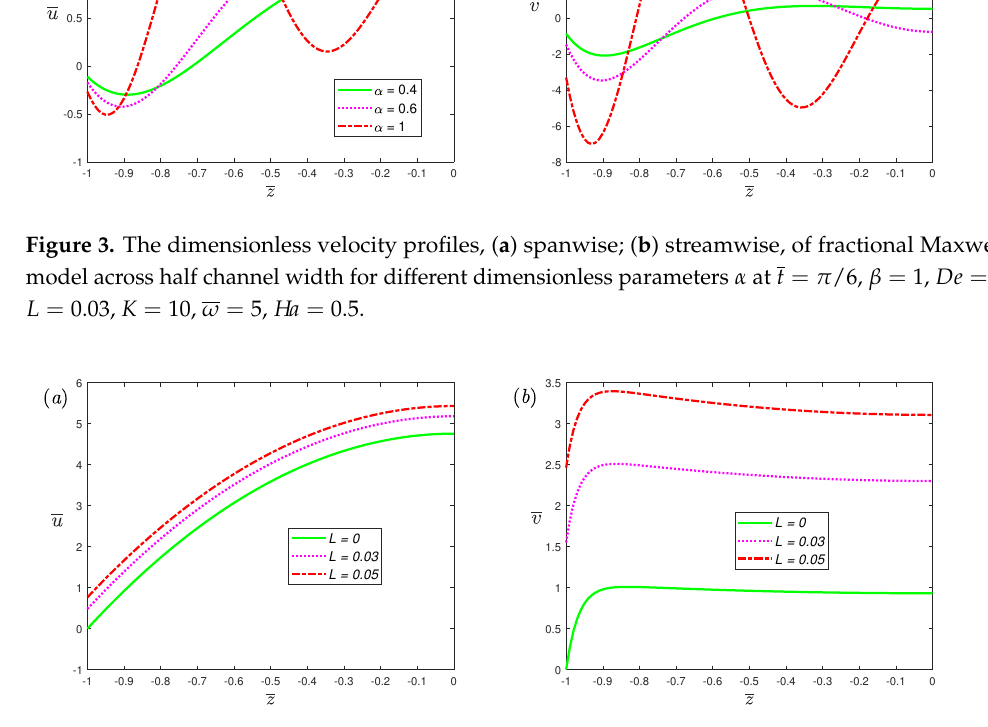
Figure 4. The dimensionless velocity, ( a ) spanwise; ( b ) streamwise, profiles of fractional Maxwell model across half channel width for different dimensionless parameters L at α = 0.7, β = 1, De = 5, K = 30, ω = 0, Ha =